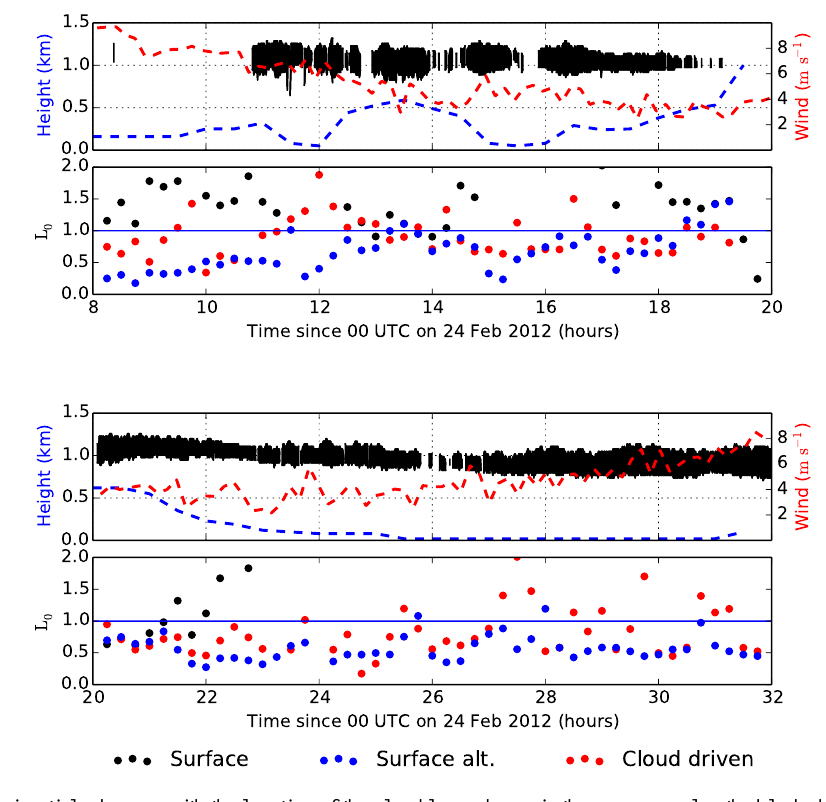
Figure 8. Scaling of the inertial subrange with the location of the cloud layer shown in the upper panel as the black shaded area. For this, cloud base is diagnosed from the lidar measurements, while radar measurements are used to infer cloud-top height. Blue dashed line represents an estimate of the interface between surface-based and cloud-driven mixed layers, approximated as the level at which vertical velocity skewness changes sign from positive to negative. Red dashed line shows the mean wind speed in the below-cloud layer. The lower panel shows the normalised transition wavelength of the inertial subrange ( L 0 ), which is sampled from the (1) cloud-driven and (2) surface-based layers, yet no lower than a 100m to avoid spurious data. Two versions of the surface-layer samples are shown: “Surface” shows L 0 normalised by the surface-layer depth, while “Surface alt.” shows the same data but normalised with the cloud-driven layer